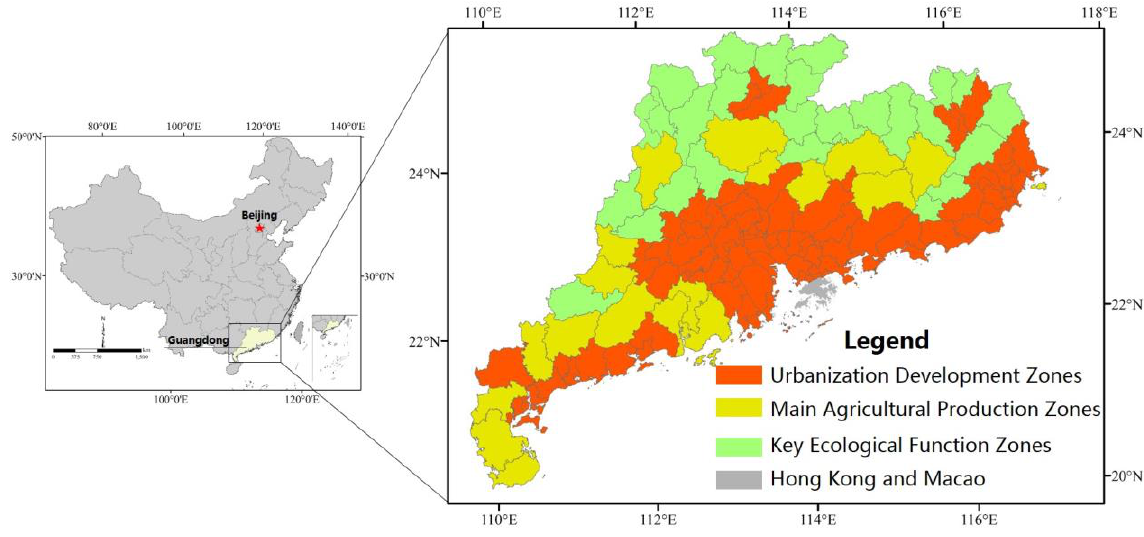
Figure 1. Scope of the study area.